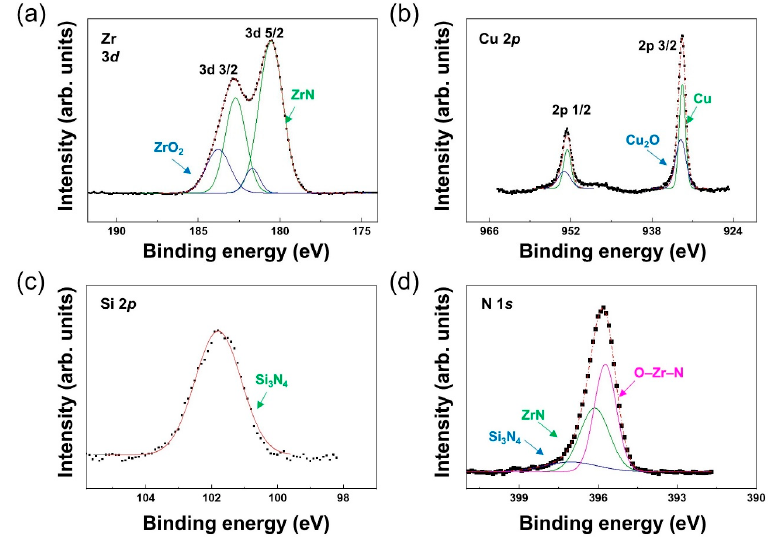
Figure 4. XPS profiles for ZrCuSiN coatings at 4 sccm. ( a ) Zr, ( b ) Cu, ( c ) Si, and ( d ) N.